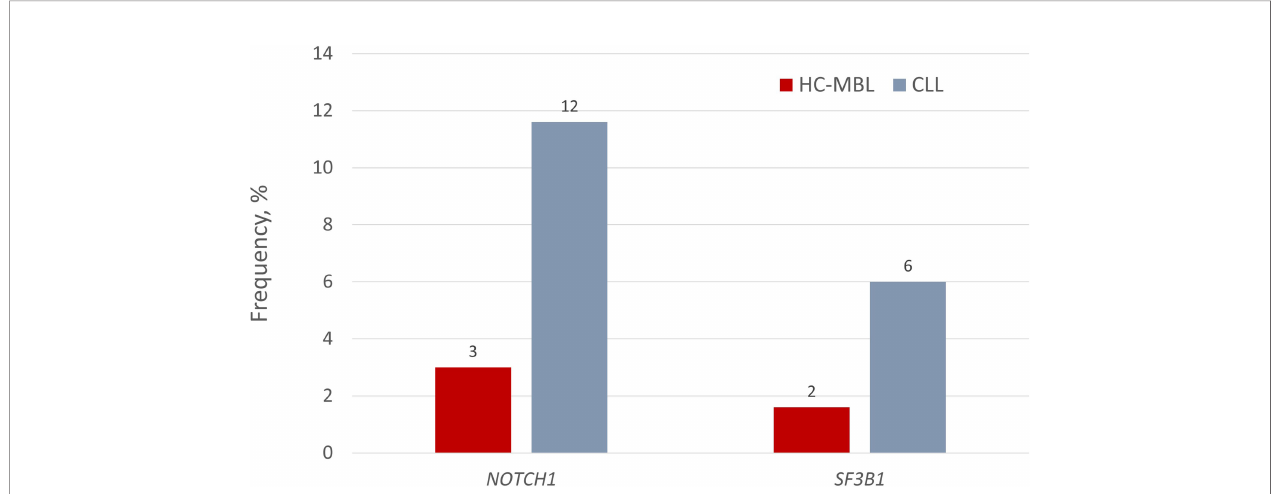
FIGURE 2 | Incidence of NOTCH1 and SF3B1 gene mutations in HC-MBL and indolent CLL. Respective values for LC-MBL were 0% in both cases. Data regarding the presence of gene mutations in LC-MBL was extracted from Agathangelidis et al. (40), data regarding NOTCH1 mutations in HC-MBL and CLL from the study by Rasi et al. (38), and fi nally, the frequency of SF3B1 mutations in HC-MBL and CLL from the studies by Greco et al. (39) and Rossi et al. (33),